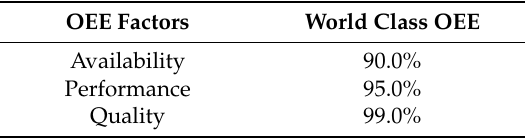
Table 1. World Class Overall Equipment E ffi